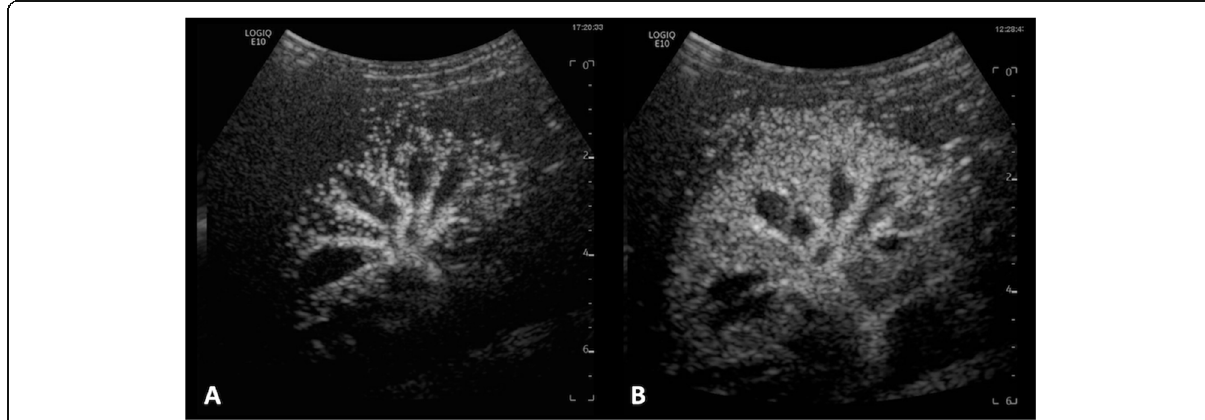
Fig. 3 Contrast enhanced ultrasound. Single frames from a contrast enhanced US video loops taken immediately after sulfur hexafluoride lipid- type A microspheres are injected and flushed with 10mls saline. a Immediately pre right renal artery angioplasty with reduced cortical perfusion to the right kidney and b immediately post angioplasty with overall improved